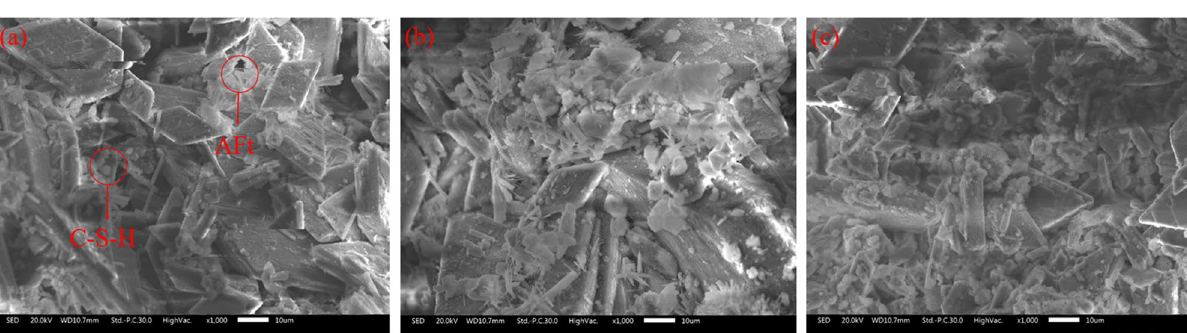
Figure 10. SEM images of cemented PG backfill samples: ( a ) PG-2-O, ( b ) PG-2-P-3.50, ( c )